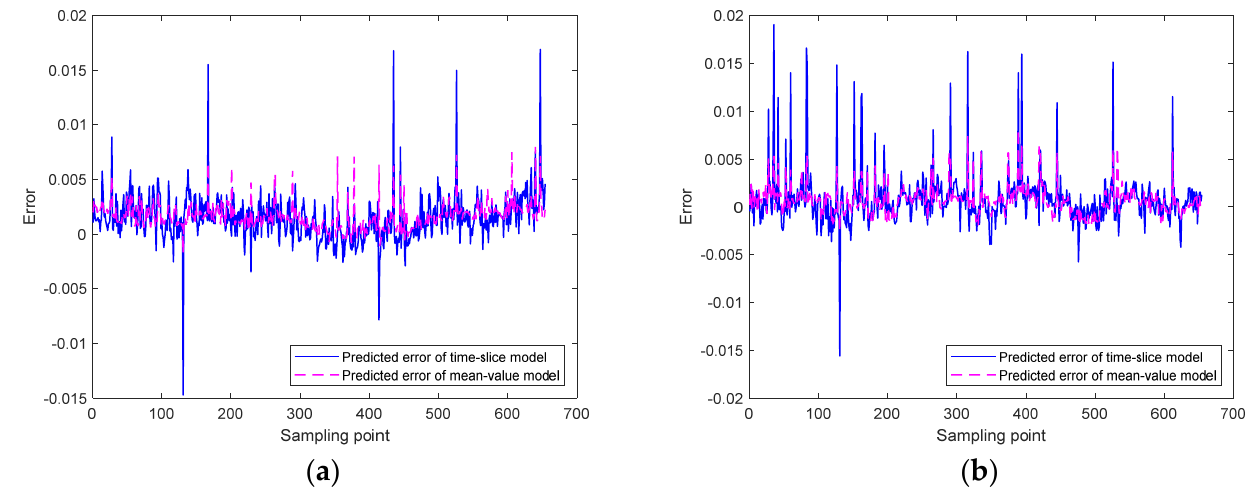
Figure 5. Multimode Mach number prediction errors of the time-slice PLS and mean-value models.